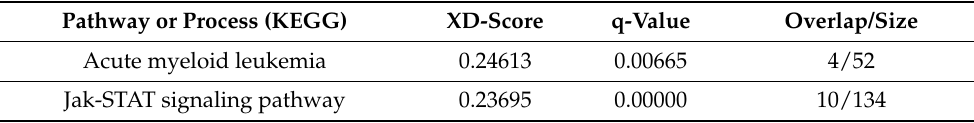
Figure 1. Summary of the role of PTPRG in physiopathology of non-neoplastic cell. Table 2. Ontology and statistical analyses were applied to identify the most represented signaling pathways and pathological processes regulated by the sub-network described in Figure 1. Analyses were done in the context of KEGG, Reactome, and GO databases and show the node participation to individual pathways. Functional relevance is proportional to the XD-score and